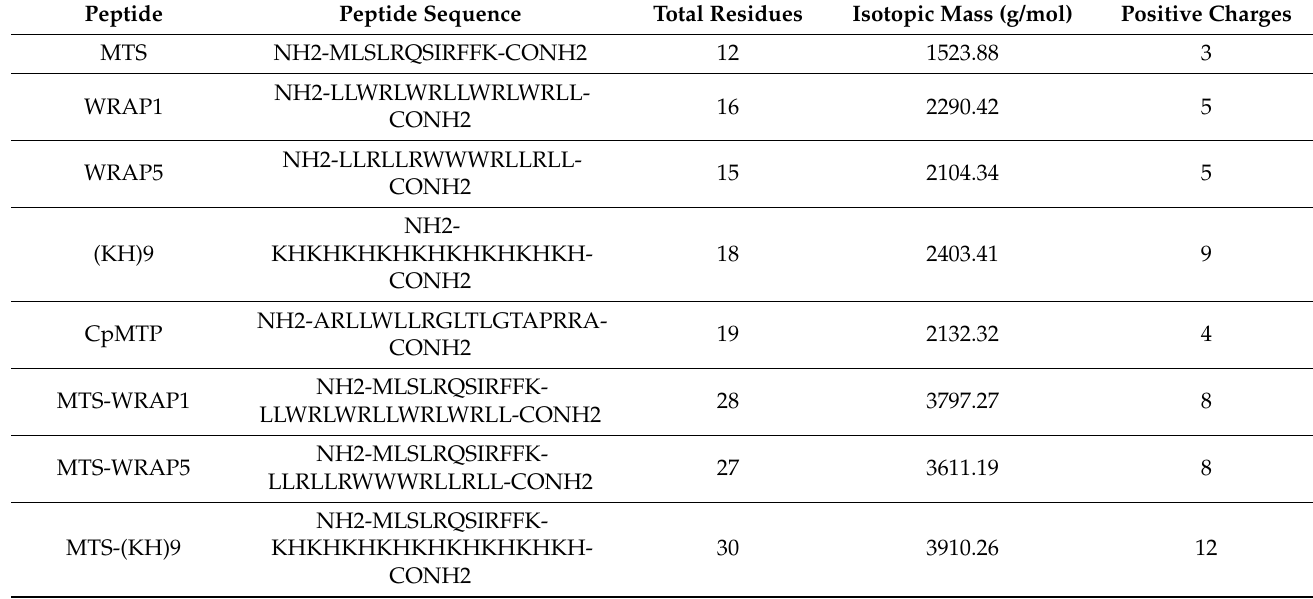
Table 1. List of the synthesized peptides and MTS sequence, including information on peptide sequence, total residues, isotopic mass and positive